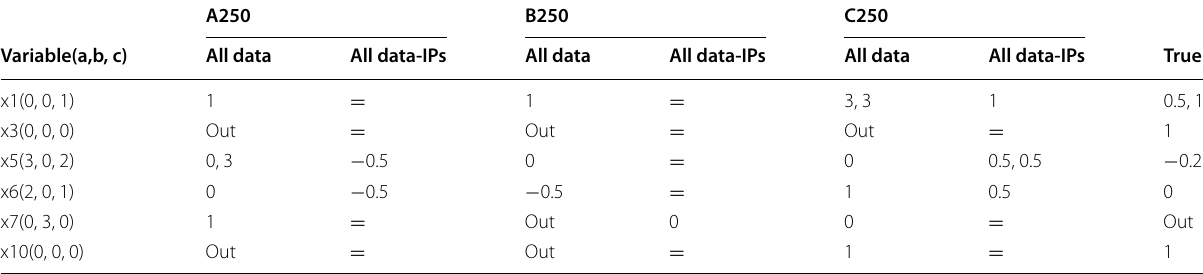
Table 2 Data A250, B250 and C250. Univariable analysis for continuous variables. “All data” and “all data-IPs” refer to FP powers obtained with complete data and after removing IPs, respectively. Variable (a, b, c) refers to the total number of IPs for each variable in each dataset, where a, b, and c stand for A250, B250, and C250 respectively. “ ” denotes same power term selected = A250 B250